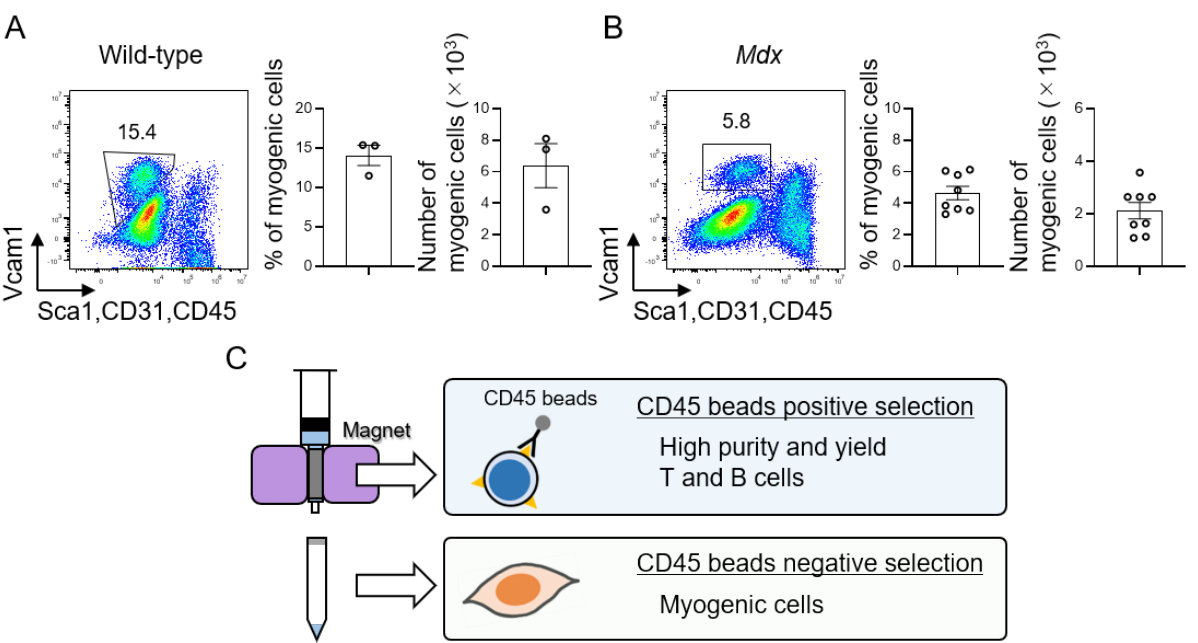
Figure 4. Isolation of myogenic cells using CD45-negative cells. ( A , B ) Flow cytometry analysis profiles of myogenic cells on day 3 after injury in ( A ) wild-type mice ( n = 3) and ( B ) mdx mice ( n = 8). The gated profiles show myogenic cells (Vcam1 + CD31 − CD45 − Sca1 − ). The percentage and number of myogenic cells were analyzed. Data represent the means ± SEM. ( C ) Schematic representation of this study. Isolation of T and B cells by CD45 beads provides high yield and purity during muscle regeneration. In addition, myogenic cells can also be isolated from the same samples.